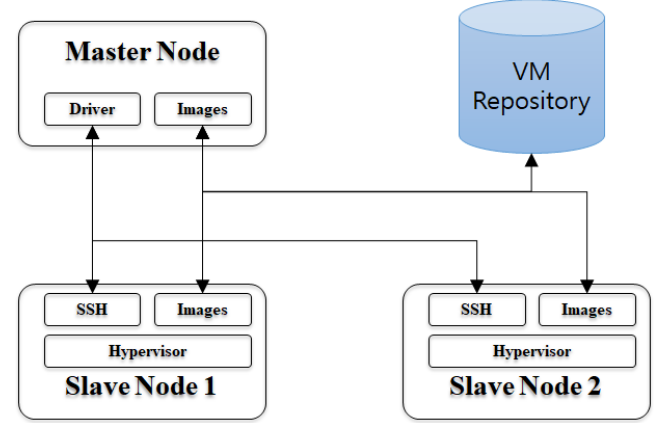
Figure 7. The Cloud computing deployment for domestic Cloud computing.